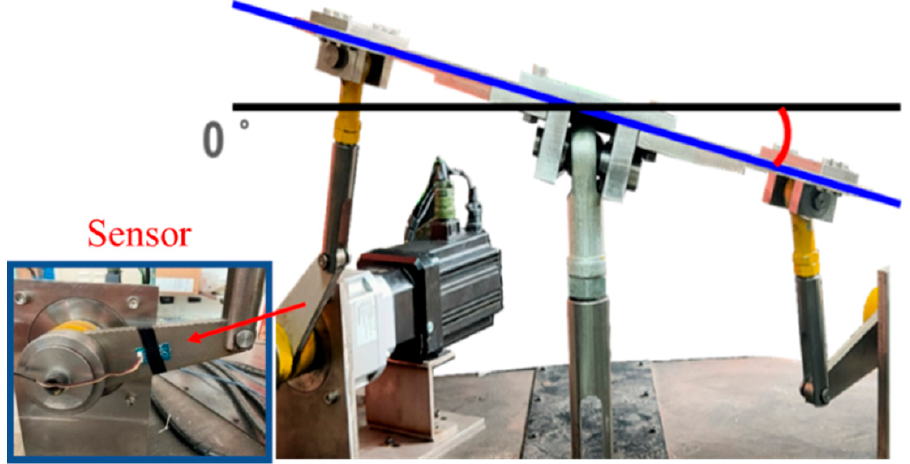
Figure 23. The angle trajectory test. Both of the roll and pitch motions tilted the platform at 0 ◦ , 5 ◦ , 10 ◦ , 15 ◦ , and 20 ◦ . When the testers controlled the movement of the upper platform, the angle of the three sets of driving motors was measured by the motion sensor. Figure 24a,b shows the motor motion simulation trajectory of the roll and pitch